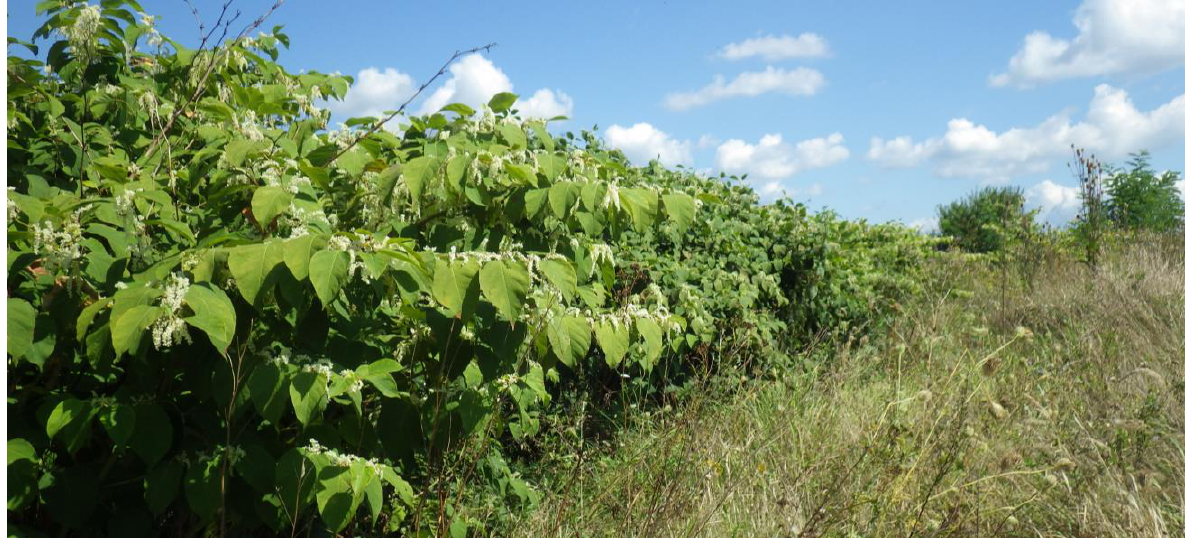
Fig. 5. Opuntia humifusa (Raf.) Raf. in Crimea Fig. 6. Bupleurum fruticosum L. in Crimea